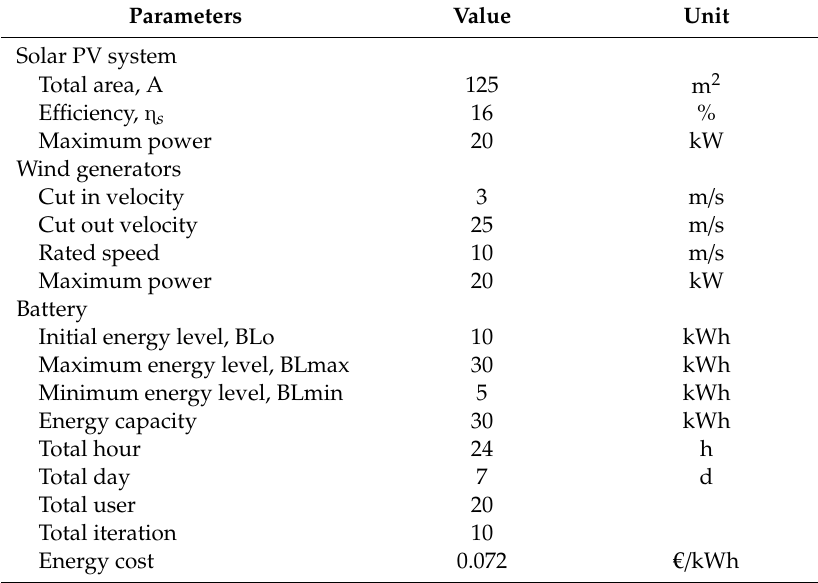
Table 1. Simulation